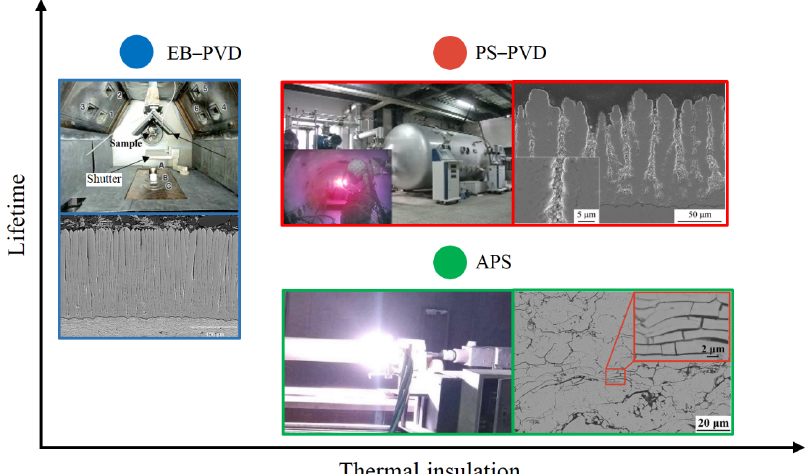
Fig. 2 Comparison of the microstructure, thermal insulation performance, and thermal cycle life of TBCs obtained by several popular preparation methods such as APS, EB-PVD, and PS-PVD. Reproduced with permission from Ref. [7], © ASM International 2015; Ref. [8], © The Nonferrous Metals Society of China and Springer-Verlag GmbH Germany, part of Springer Nature 2020; Ref. [9], © ASM International 2009; Ref. [10], © The Nonferrous Metals Society of China and Springer-Verlag